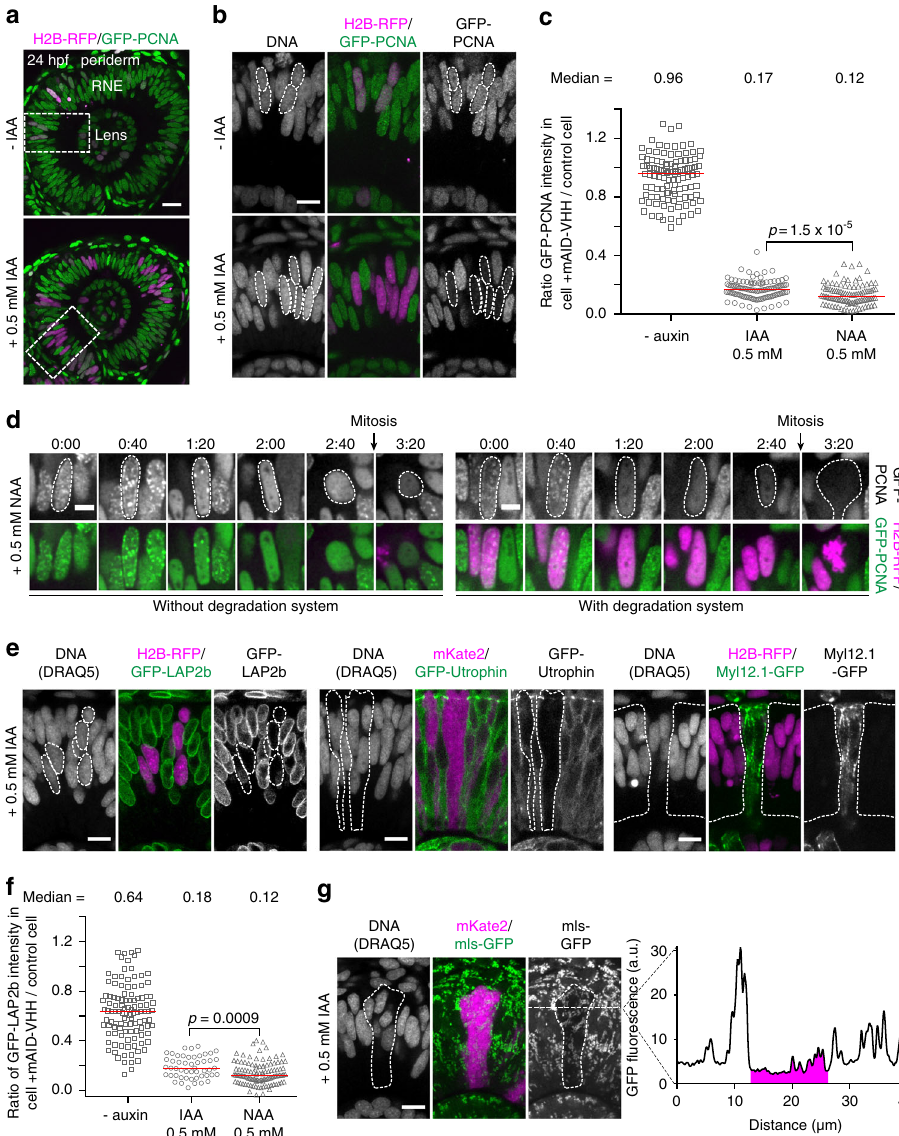
Fig. 6 Auxin-dependent degradation of GFP-tagged proteins by mAID-nanobodies in zebra fi sh. a Eye of a 24 hpf zebra fi sh embryo in Tg(bactin:GFP-PCNA) mosaically injected with RNAs of TIR1, mAID-nanobody and H2B-RFP RNA to visualize affected cells. The dashed box shows the area displayed in b . RNE, retinal neuroepithelium. Scale bar: 20 μ m. b GFP-PCNA degradation in the presence of IAA. Dashed line: Nuclei of cells expressing the degradation system. Scale bar: 10 μ m. c Comparison of GFP-PCNA degradation at 22 hpf in response to IAA and NAA treatment. 1 represents no degradation and 0 represents complete degradation. Bars represent median, − auxin control ( n = 11, 110 cells), IAA ( n = 11, 108 cells), NAA ( n = 11, 108 cells). Signi fi cance according to a two-tailed Mann – Whitney test. d Time-lapse imaging of GFP-PCNA degradation in response to NAA in cells without (H2B-RFP negative, left panel) and with degradation system (H2B-RFP positive, right panel). Scale bar: 5 μ m. e Degradation of GFP-fusion proteins localized to different cellular structures. Nuclear membrane-localized Lamina-associated polypeptide 2 Tg(bactin:GFP-LAP2b) , fi lamentous actin binding Utrophin fragment Tg(bactin:GFP-Utrophin ) and actomyosin-associated non-muscle myosin II light chain Tg(bactin:Myl12.1-GFP) . Cells containing the degradation system were visualized by cytoplasmic H2B-RFP or cytoplasmic mKate2 RNA co-injection. Scale bar: 10 μ m. f Comparison of GFP-LAP2b degradation in response to IAA and NAA treatment as in c . Bars represent median, − auxin control ( n = 11, 110 cells), IAA ( n = 5, 50 cells), NAA ( n = 11, 111 cells). Signi fi cance according to a two- tailed Mann – Whitney test. g Depletion of GFP from mitochondria, Tg(Eef1a1:mls-GFP) . Cells containing the degradation system show cytoplasmic mKate2 signal. GFP intensity pro fi le along dashed line is plotted, magenta corresponds to the degradation area. Scale bar: 10 μ m. All data shown in this fi gure are representative examples from at least two independent biological features: 2,3 (i) robust conditional and rapid degradation of pro- and functional recovery of the targeted protein (Figs. 3 and 4), teins localized to distinct compartments: subcellular and cellular and (iv) applicability in human tissue or cell culture and in a structures including chromatin, the nuclear envelope, the cell vertebrate model organism (Figs. 2 – 6). cortex and cytoplasmic actin fi laments (Figs. 2 – 4 and 6), (ii) By directing SCF TIR activity towards the GFP, the mAID- depletion of membrane proteins and proteins in context of large nanobody can in principle target any protein for degradation macromolecular assemblies such as the nuclear lamina or the regardless of their sequence, size and structure. Even a protein APC/C (Figs. 3, 4, and 6), (iii) reversibility after auxin removal localized to a compartment with no SCF activity such as